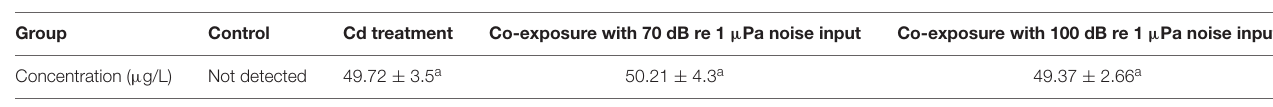
TABLE 2 | Waterborne Cd 2 + concentrations measured for the different groups.